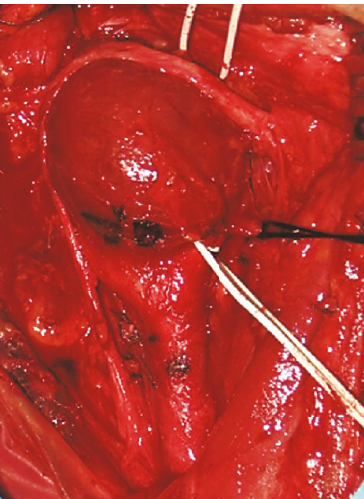
Figure 7: Paraganglioma of carotid tumor after surgical resection was 3cm in diameter.